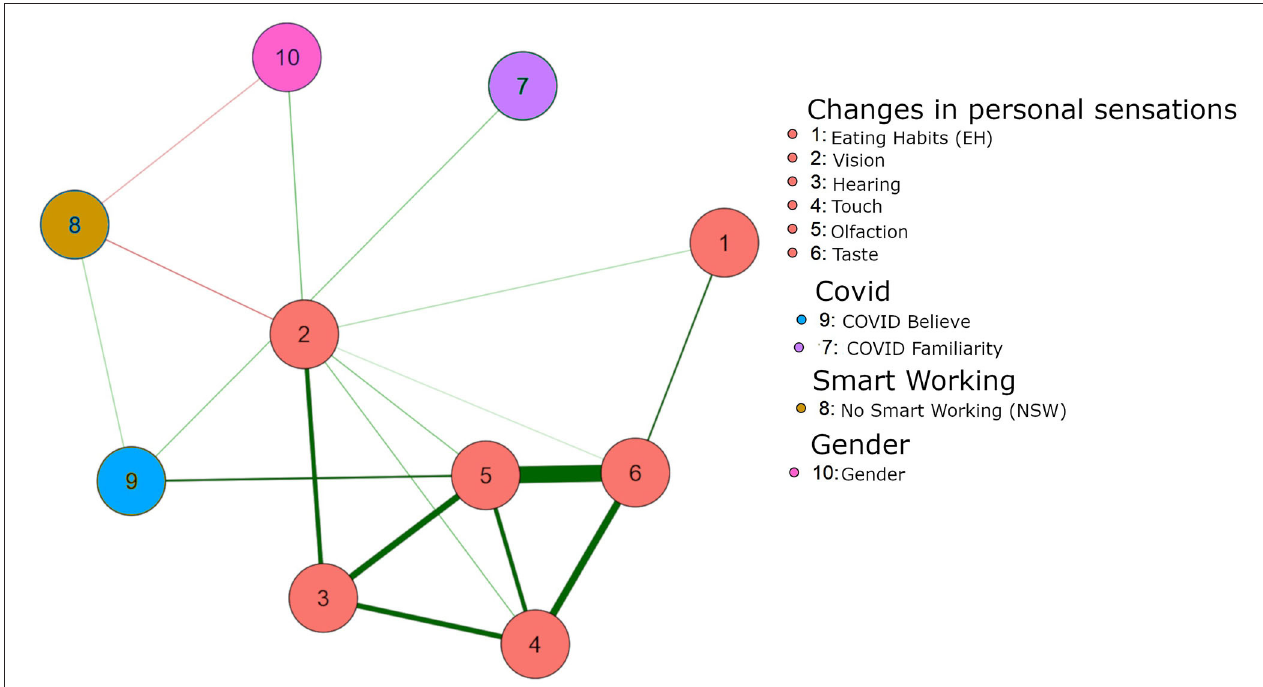
FIGURE 2 | Green lines indicate positive associations. Red lines indicate negative associations. Edges represent the direct association between two edges. The nodes indicate the variables as follow: 1 Eating Habits (EH); 2 Vision; 3 Hearing; 4 Touch; 5 Olfaction; 6 Taste; 7 Covid F; 8 NSW; 9 Covid B; 10 Gender.